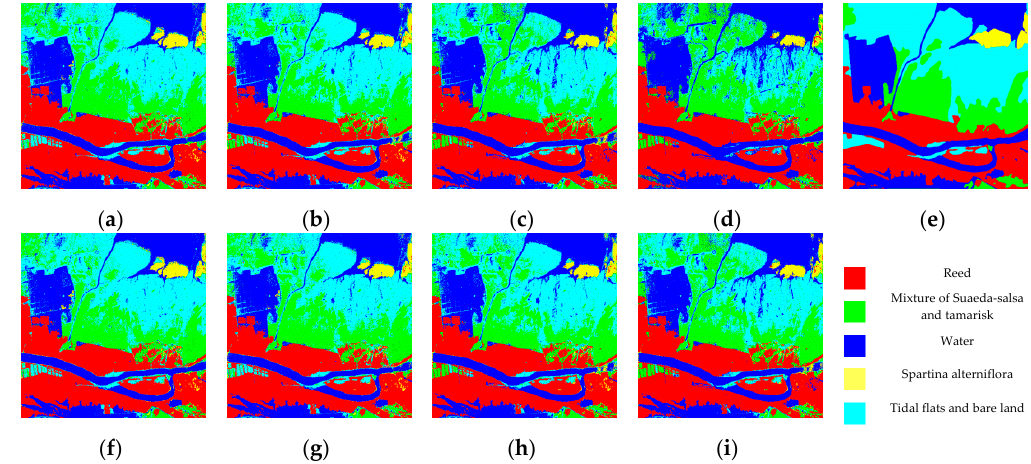
Figure 9. Classification results of 20x training sample with 2% disturbance level. ( a ) ~ ( d ) CNN model classification results (batch size = 40, 120, 300, and 580); ( e ) ground truth image, ( f ) ~ ( i ) F-R CNN model classification results (batch size = 40, 120, 300, and 580).